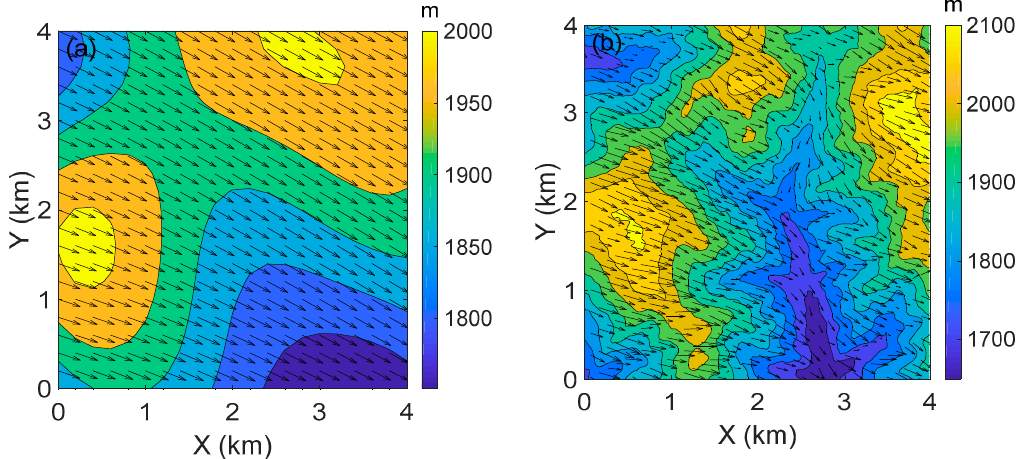
Figure 14. Topography (m) and near-ground (10 m AGL) wind vectors (m / s), 16:00 on 22 May 2018: ( a ) WRF simulation; ( b ) WRF-CFD simulation.